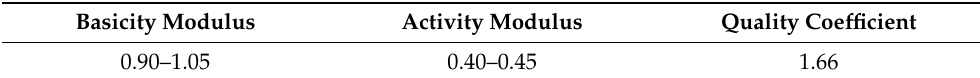
Table 2. Modular characteristics of slag.